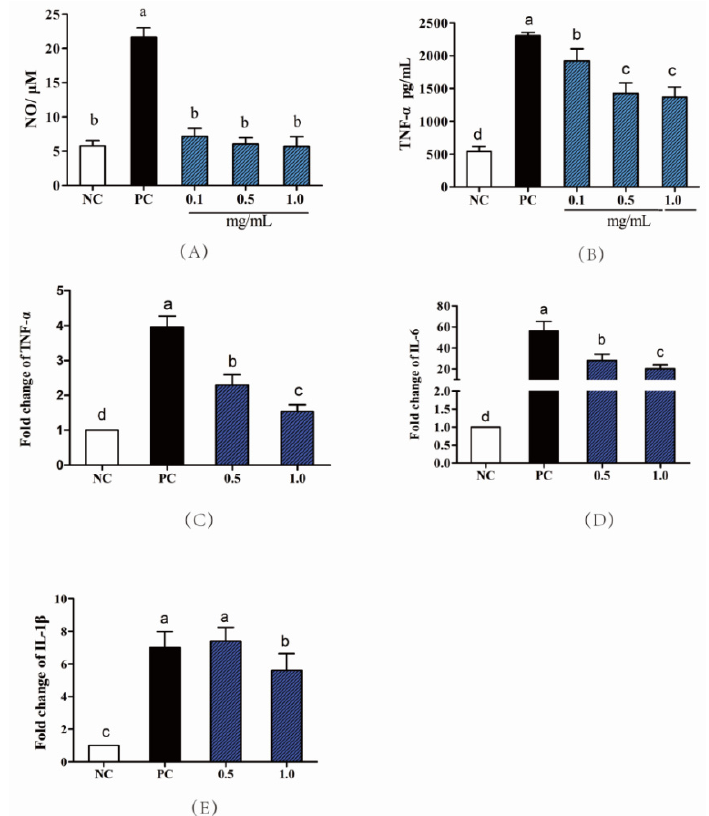
Figure 2. Anti-inflammatory activity of GP in RAW264.7 cells. ( A ) Effects of GP on the secretion of